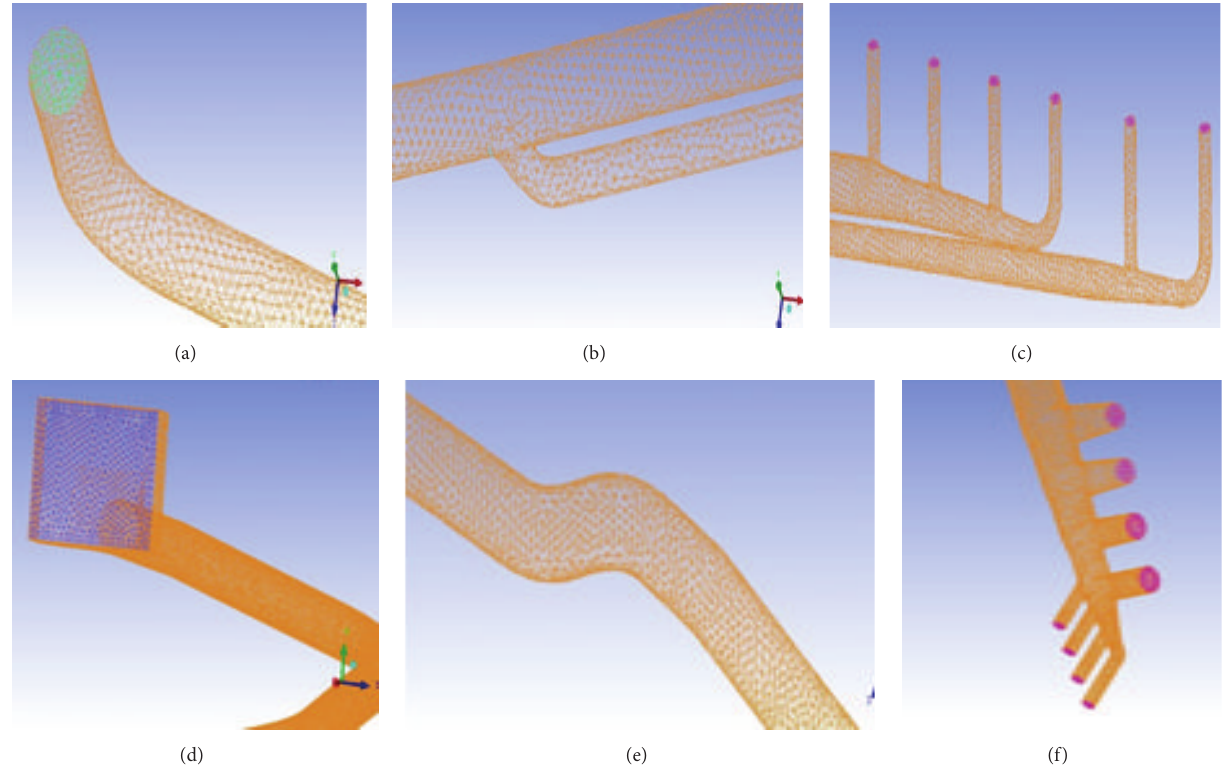
Figure 2: Meshing: Tunnel 2 (a–c) and Tunnel 3